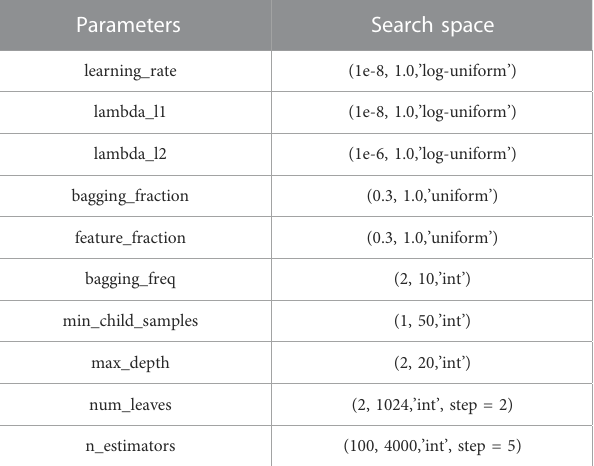
TABLE 1 Hyperparameter settings of LightGBM used for the Bayesian optimization. Parameters Search